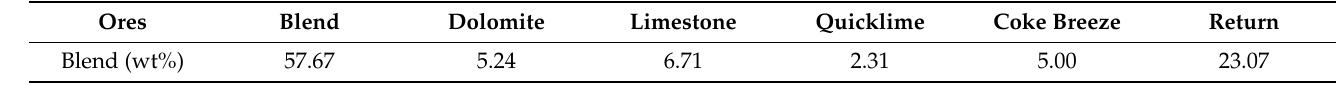
Table 3. Ore mixing scheme.